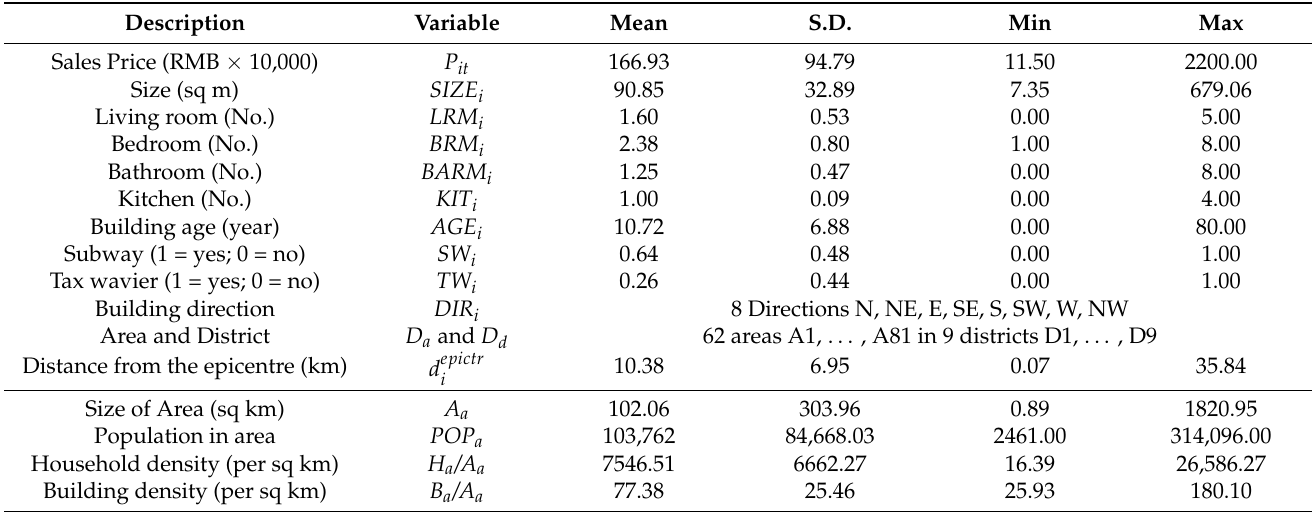
Table 1. Descriptive